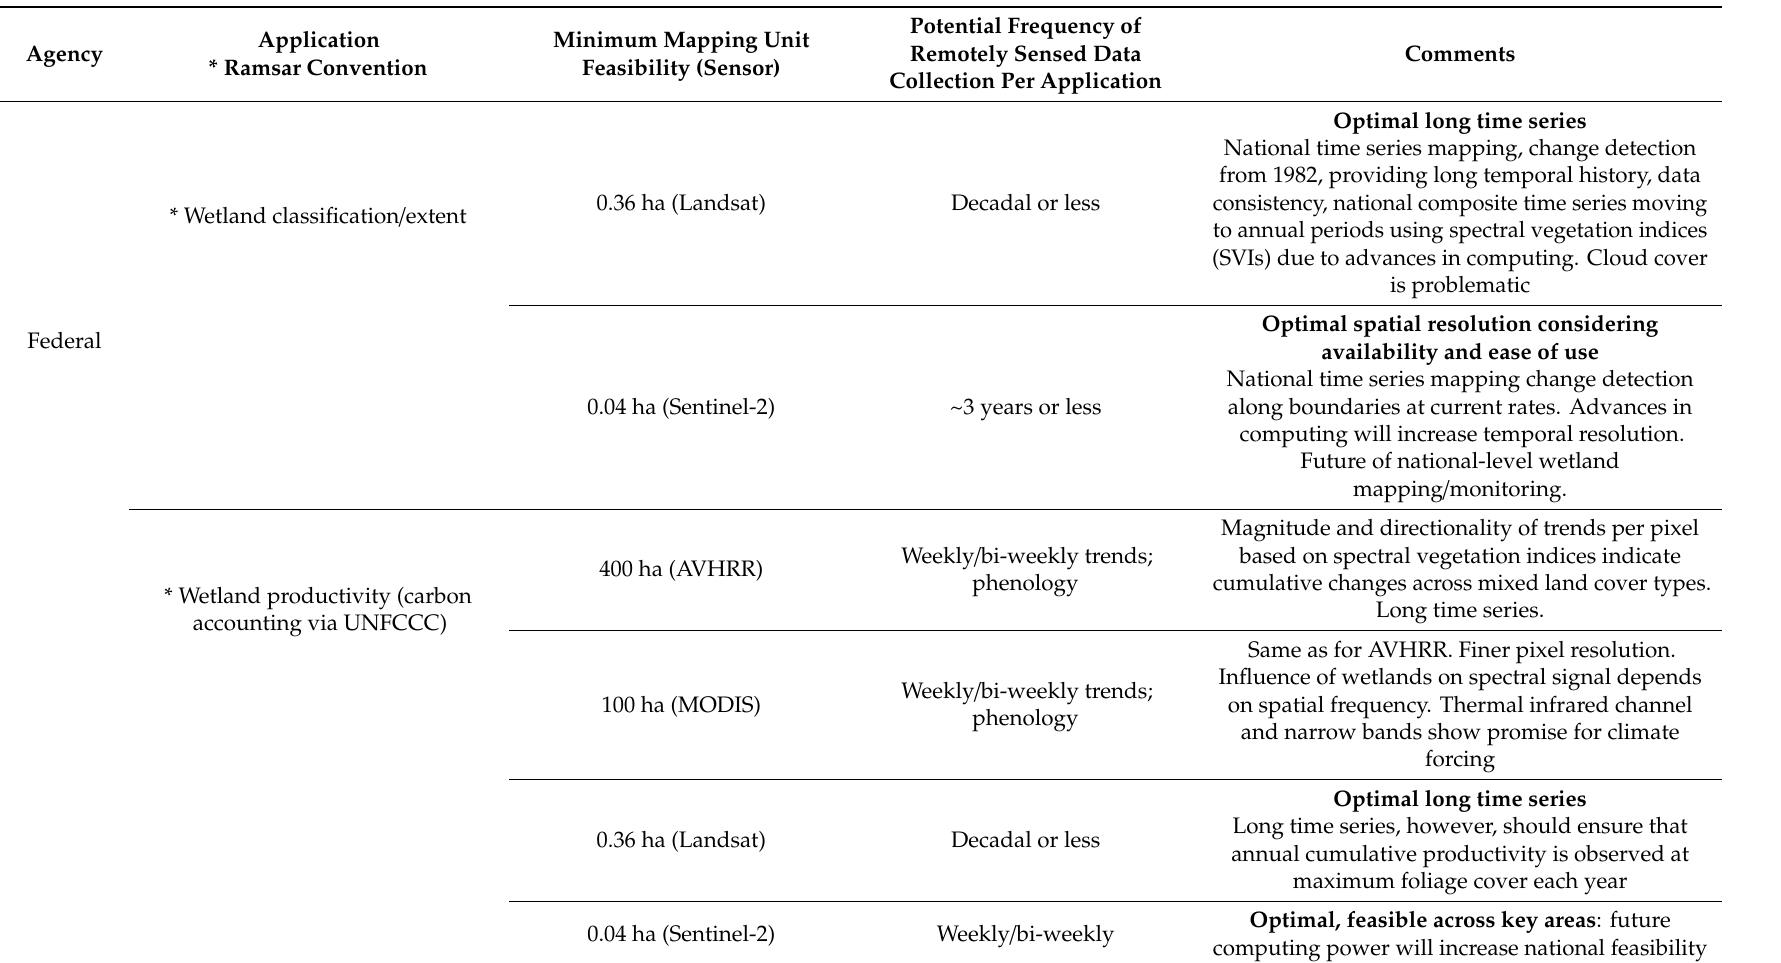
Table 3. Remote sensing derivative products, classes, and descriptions used to study wetland ecosystems. Asterisk (*) refers to applications that include mapping of processes required by the Ramsar Convention on Wetlands [2] for baseline inventory and monitoring of